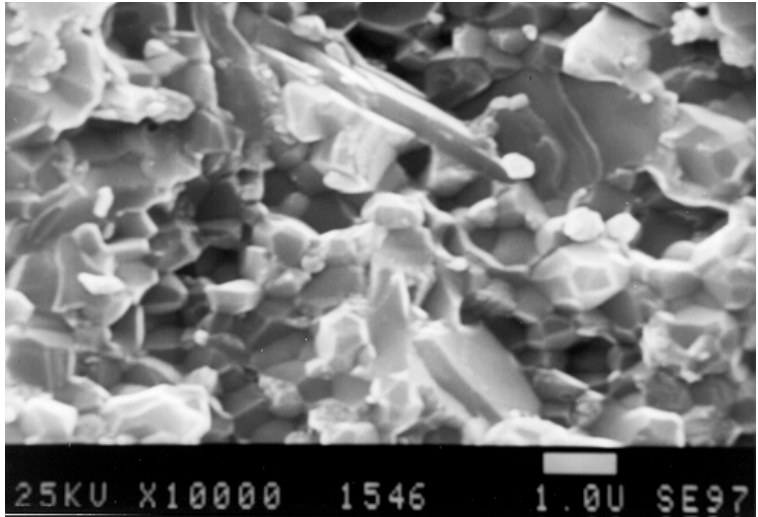
Figure 31. Fractured surface of the original “Biolox delta”. Table 2. Material properties of original “Biolox delta”.